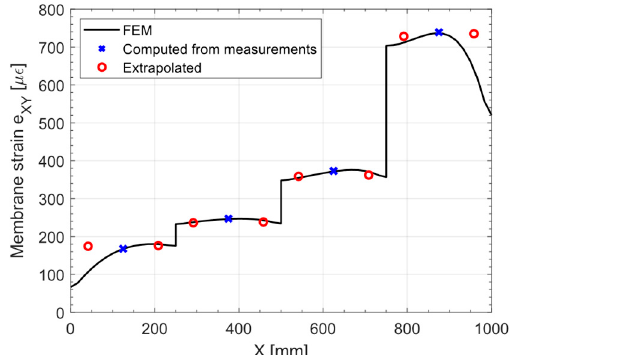
Table 5 . Shear loading: selected polynomial pre-extrapolation orders.